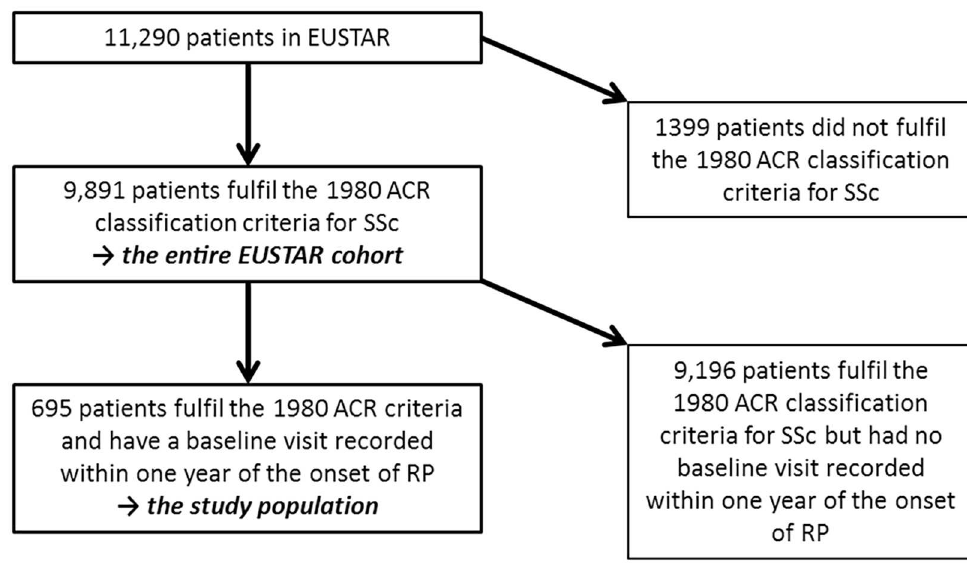
Fig 1. Flow chart of patients included and excluded in the